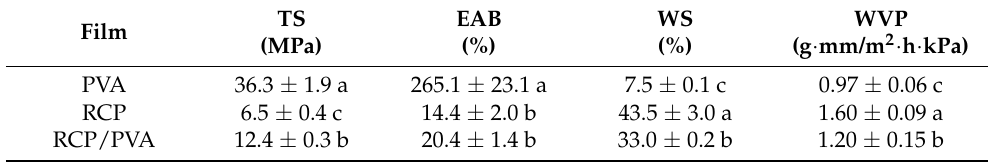
Different letters within the same column indicate significant differences ( p <